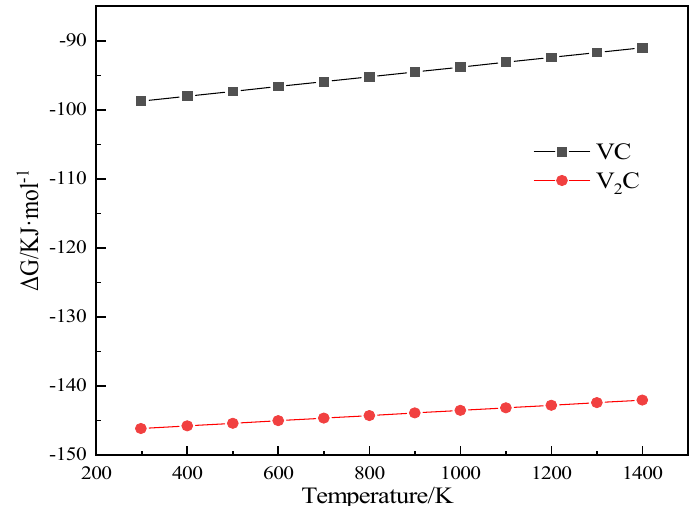
Figure 6. Temperature dependence of ∆G of VC and V 2 C during V-C reaction.